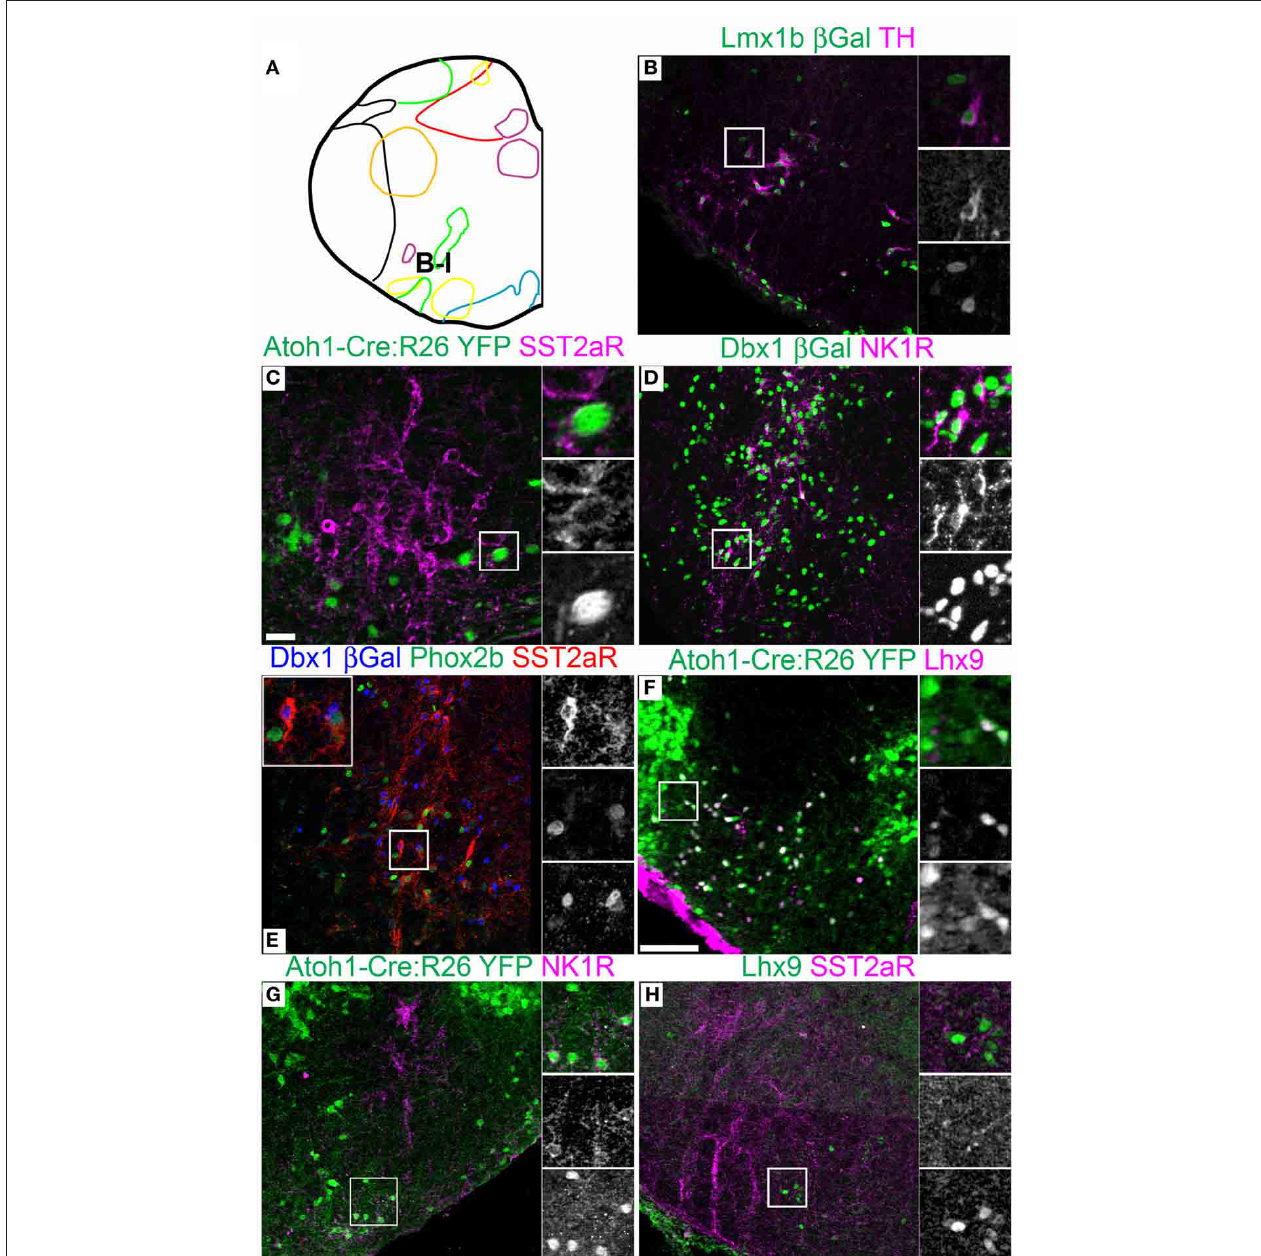
FIGURE 6 | Pseudo-rhombomere 8 specific patterns of gene expression. Pseudo-color fluorescent confocal mosaic images from P0 transgenic mouse at the level of pseudo-rhombomere8. (A) Schematic image modified from Figure 2E indicating location of co-expressing populations shown in (B–H) . (B–H) Images from Lmx1b - β gal (B) , Atoh1 -Cre; Rosa26YFP (C,F,G) , Dbx1 - β gal (D,E) ,and wild type (H) mice showing localization of lineage